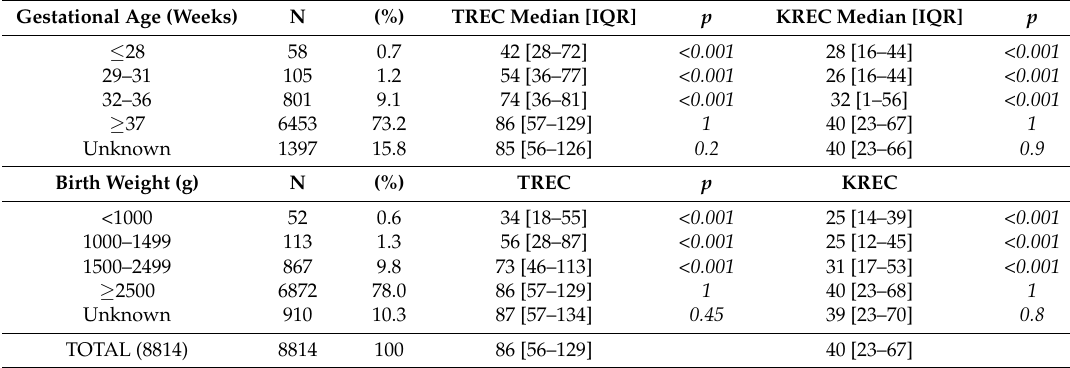
Table 1. Results of TREC/KREC PCR-assay of DBS in relation to gestational age (GA) and birth weight